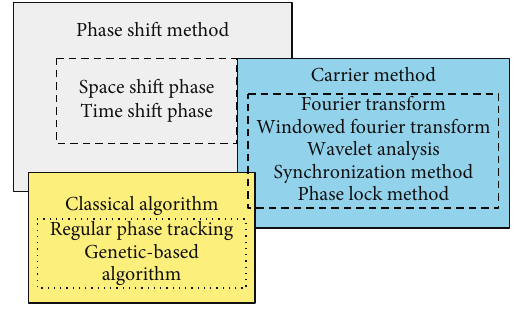
Figure 2: Phase extraction